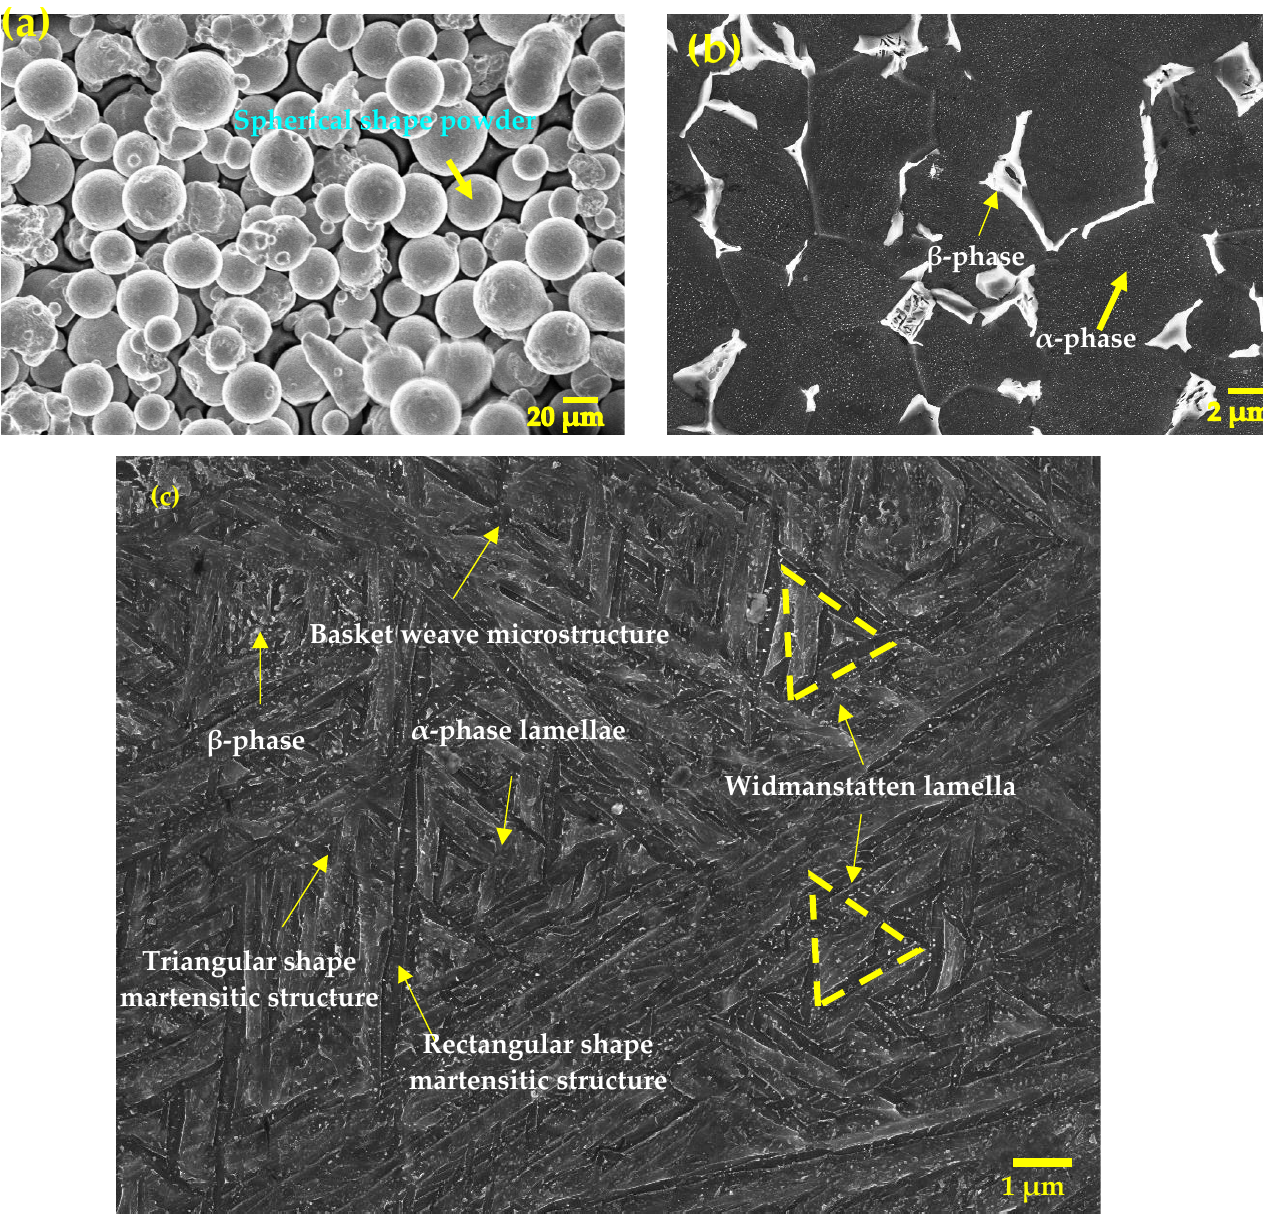
Figure 2. FESEM micrograph of: ( a ) gas-atomized powder, ( b ) CACF structure with α - and β -phase, ( c ) SLM-produced structure with α -phase, β -phase, and martensite.